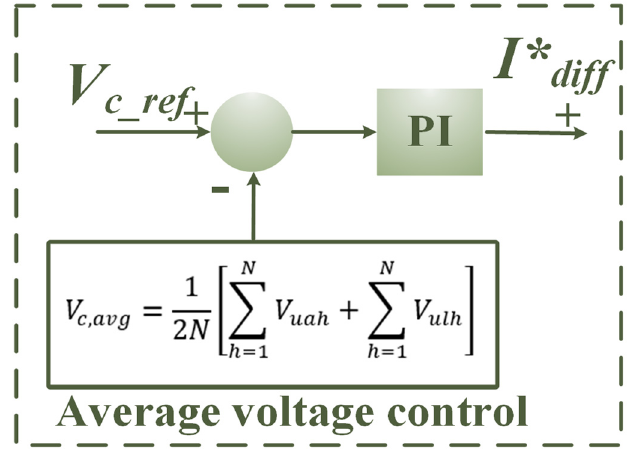
Figure 9. Average voltage control.